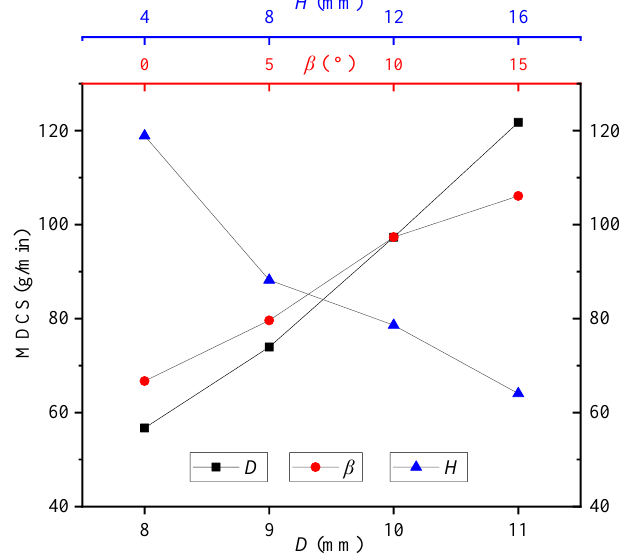
Figure 16. Influence of the sieve hole parameters on the MDCS. Diameter ( D ); inclination angle ( β ); and depth ( H ).